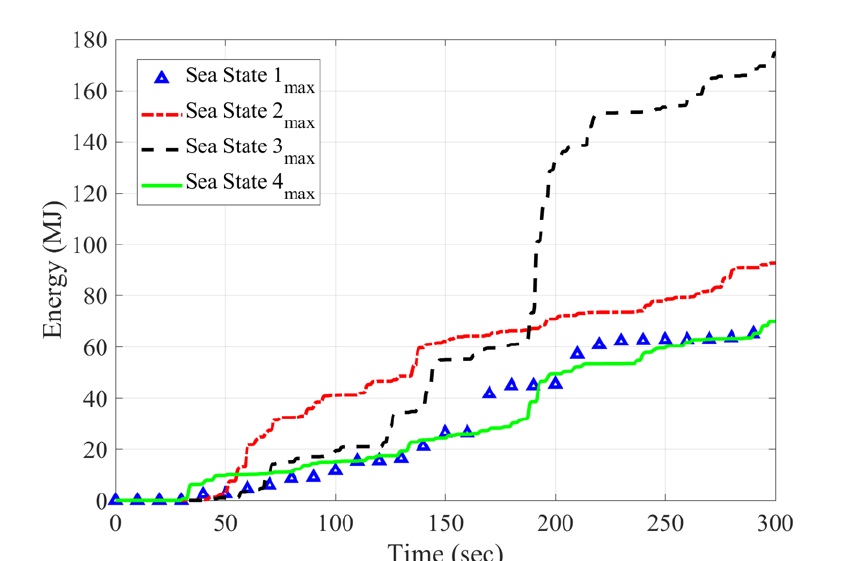
Figure 19. Harvested energy for all varying sea states.